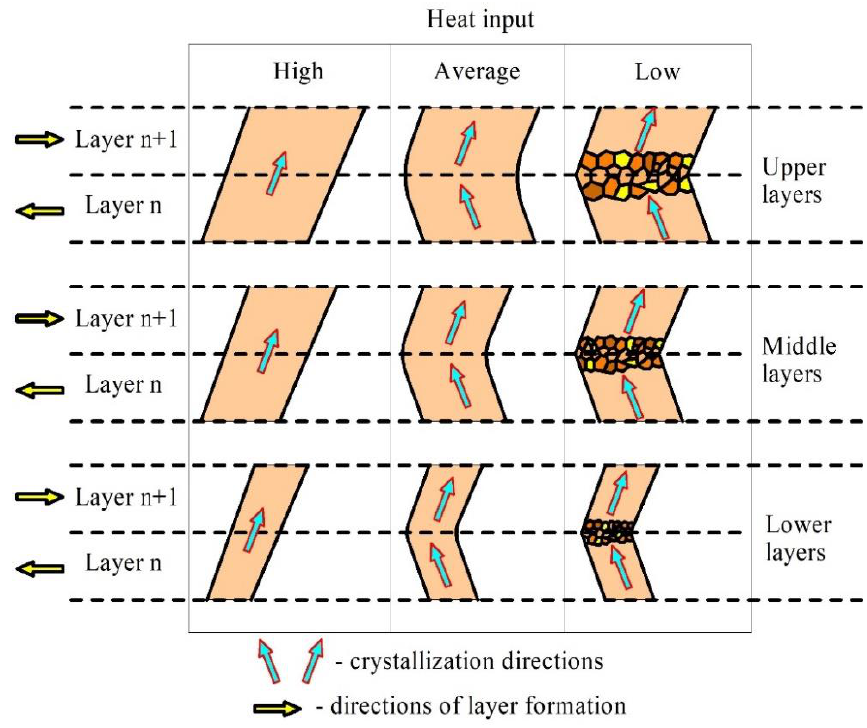
Figure 18. Diagram illustrating the grain growth as depended on the heat input. The second type of microstructures characterized by zigzagged columnar grains (Figure 18, central part) that were formed at medium heat input conditions when grains grew following the heat removal direction alternating with the deposition pass direction (Figure 19). Such a zigzagged grain growth mechanism was reported elsewhere [37].